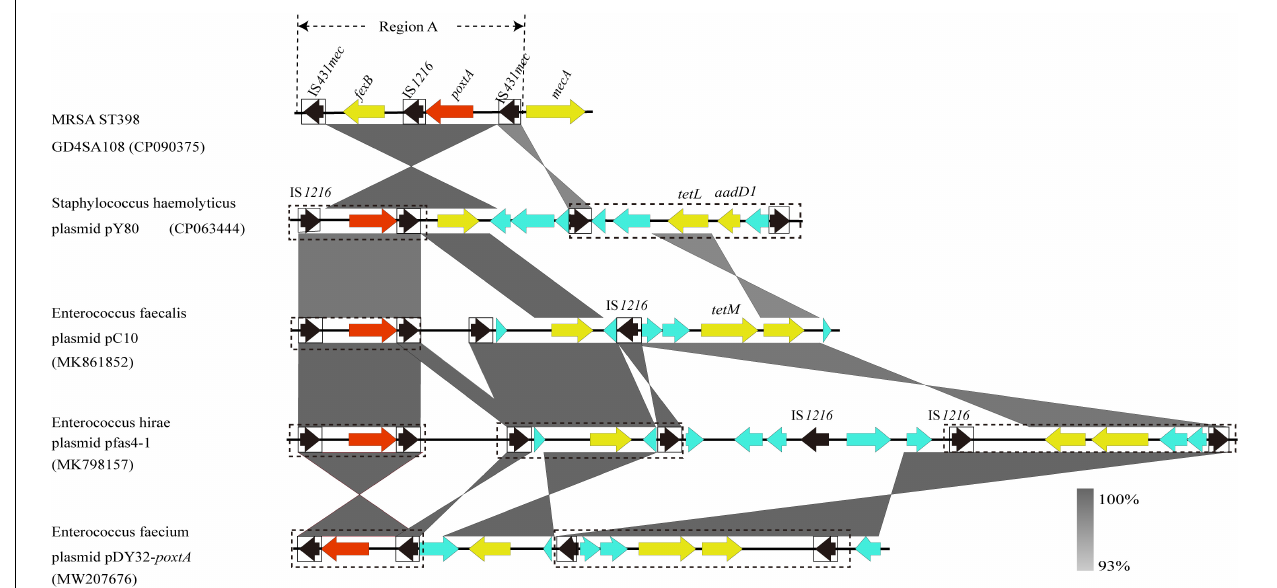
FIGURE 5 | Schematic presentation of the genetic context of poxtA -flanking regions in the chromosomal DNAs of the isolate GD4SA108 compared with the corresponding regions of other strains in the NCBI database. Regions of > 93% homologies are shaded gray. Differently colored arrows indicate the direction of transcription of the different genes. The poxtA gene is shown as a red arrow, and yellow arrows indicate other resistance genes. Genes with unknown or other functions are depicted in light blue. MGEs are indicated as black dotted boxes. Insertion sequences are indicated as black boxes, with the black arrow inside the box showing the transposase gene. Region A could form a circular